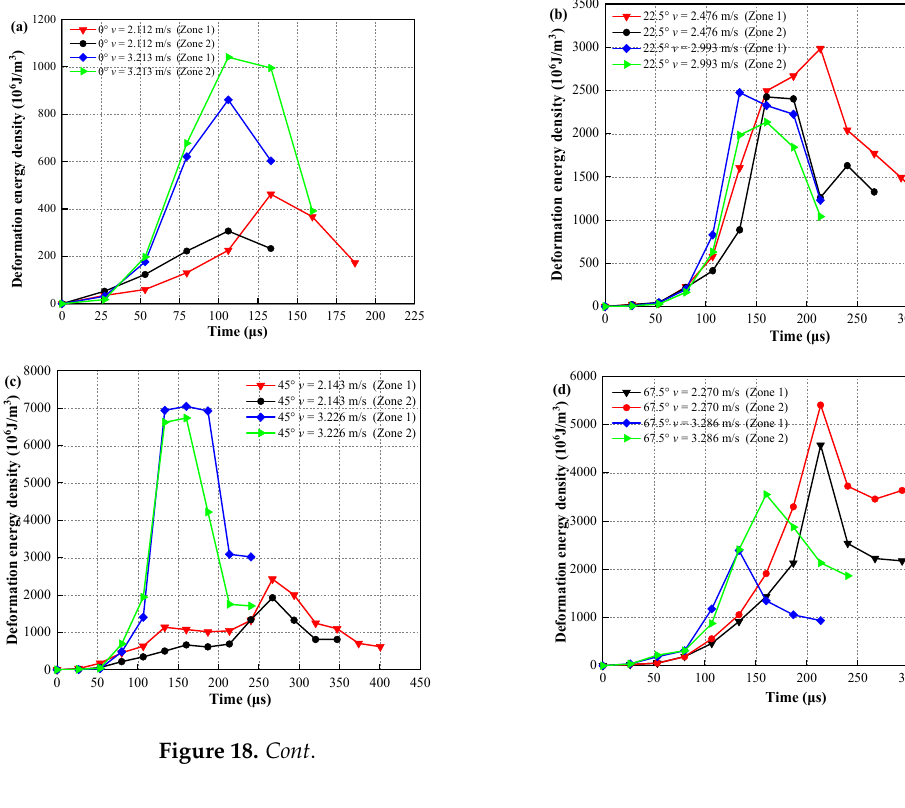
Time ( μ s) Figure 18. Deformation energy density evolution curves of coal specimens. ( a ) 0°, ( b ) 22.5°, ( c ) 45°, ( d ) 67.5°, ( e ) 90°.